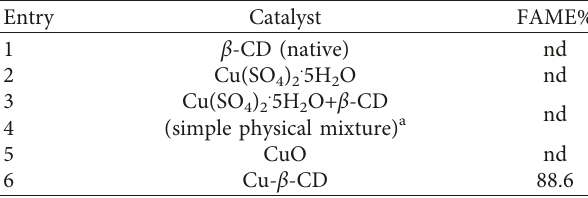
Table 1: The catalytic activity of the catalysts.